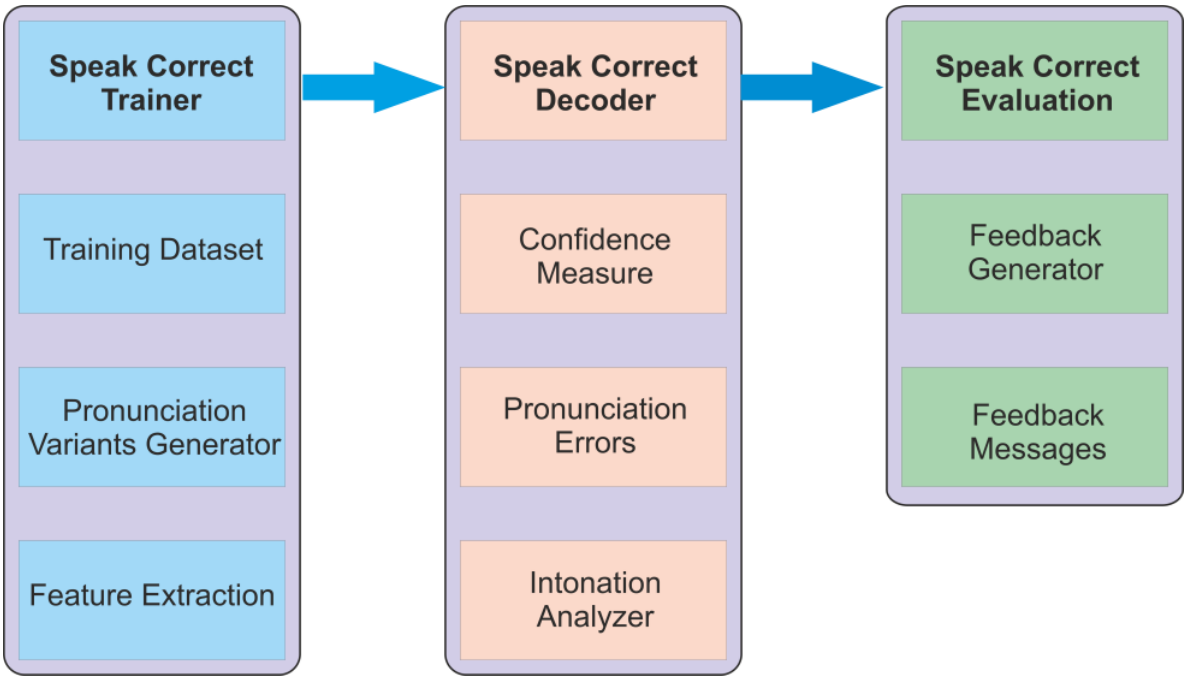
Figure 1. Speak Correct with phonetic analyzer overview. At the phonetic phase, skilled annotators insert the utterances, which are then mapped and generated using automatic voice recognition and backed by trained occurrences in the format of a grammar structure (Lattice graph) for the intended word. Mistakes are recognized and evaluated, and the decoder and assessment stages are used to assess the